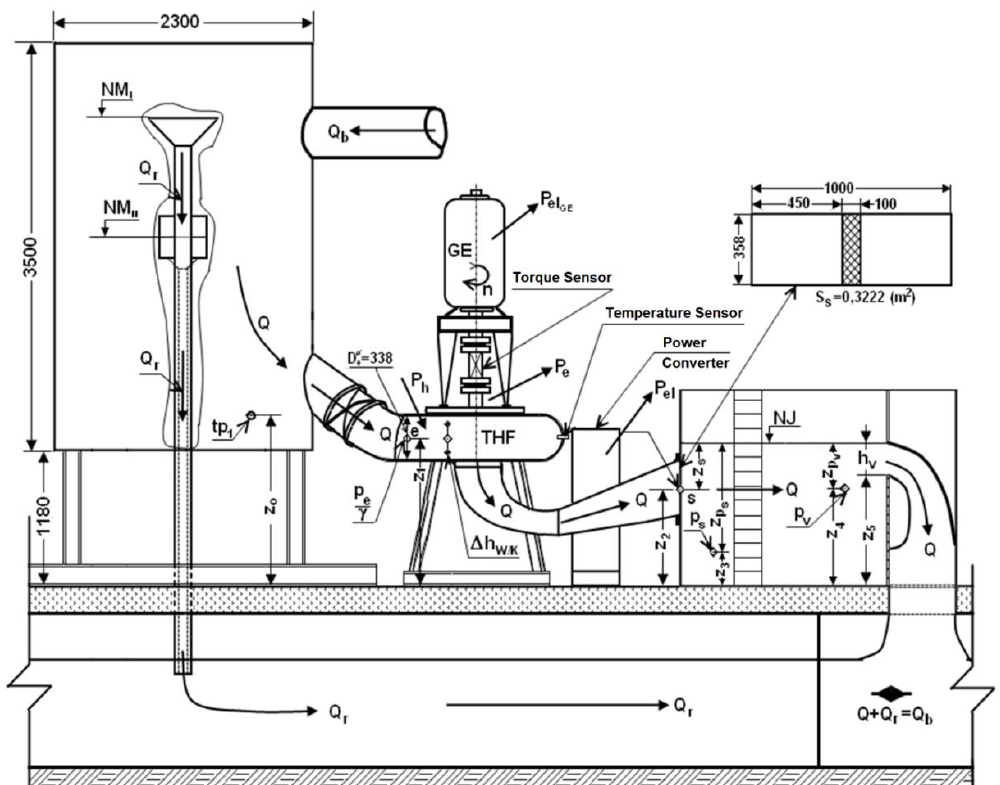
Figure 11. Experimental laboratory installation layout.